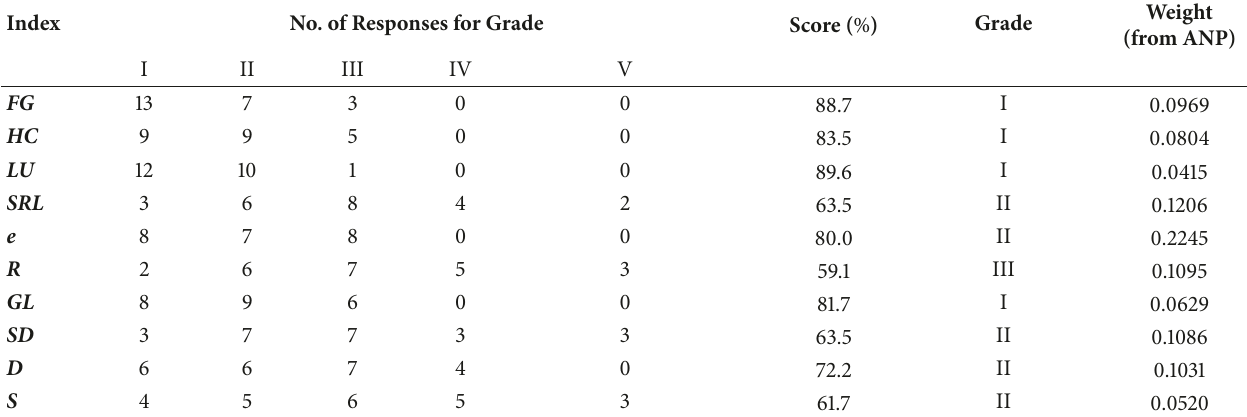
Table 13: Assessment index system and associated grades and weights.